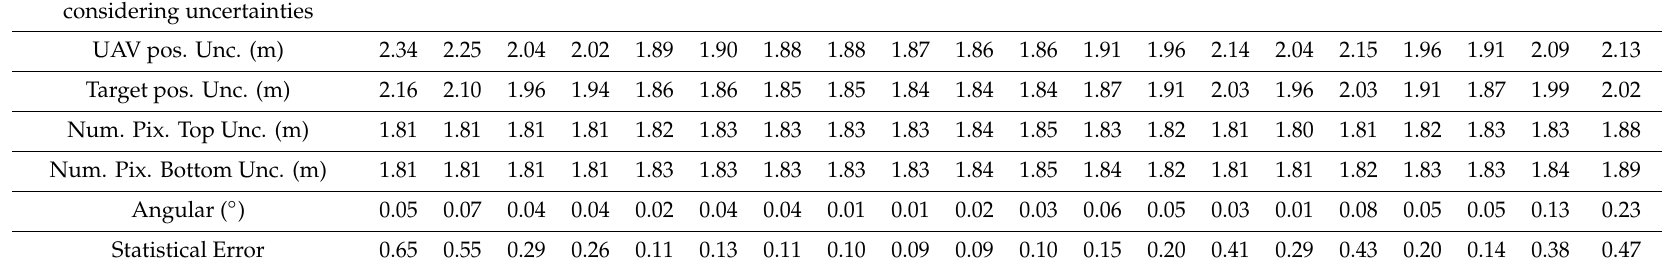
Real Target Height (m) Height Estimation considering uncertainties UAV pos. Unc. (m) Target pos. Unc.